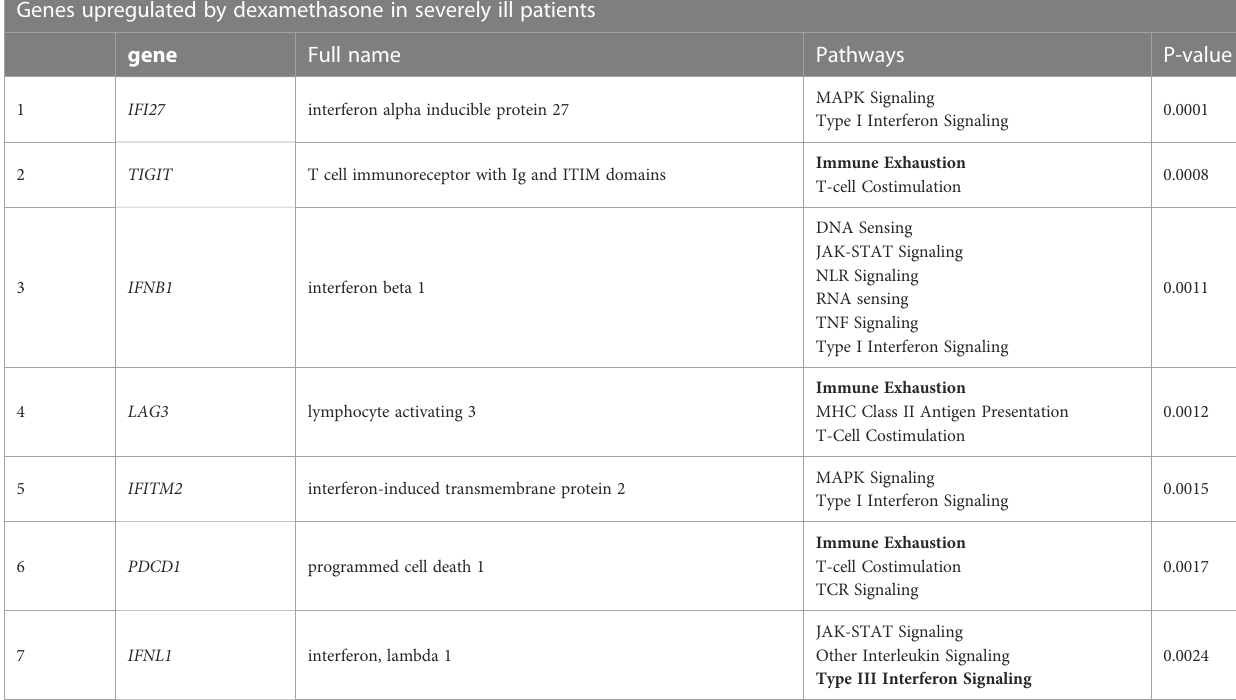
TABLE 1 List of genes differentially expressed by dexamethasone treatment in severe COVID-19 patients. Genes upregulated by dexamethasone in severely ill